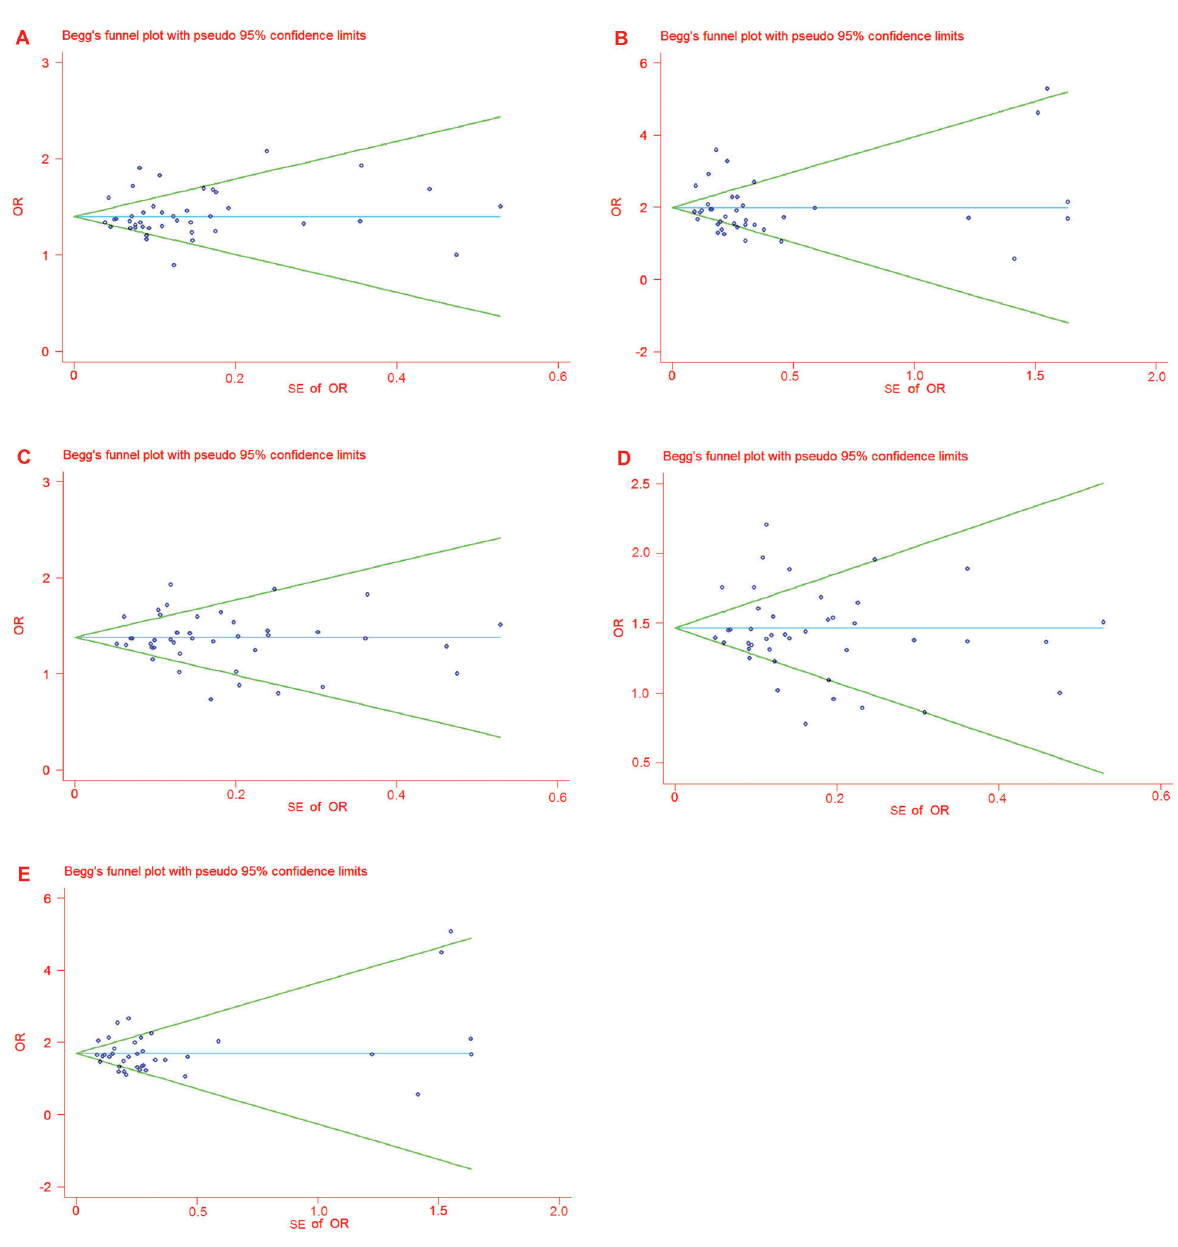
Figure 6. Funnel plot analyses for odds ratios. Panel A , Funnel plot analysis for odds ratios of allele T compared with allele G in the studies analyzed. Panel B , Funnel plot analysis for odds ratios of genotype TT compared with genotype GG in the studies analyzed. Panel C , Funnel plot analysis for odds ratios of genotype GT compared with genotype GG in the studies analyzed. Panel D , Funnel plot analysis for odds ratios of the dominant model. Panel E , Funnel plot analysis for odds ratios of the recessive